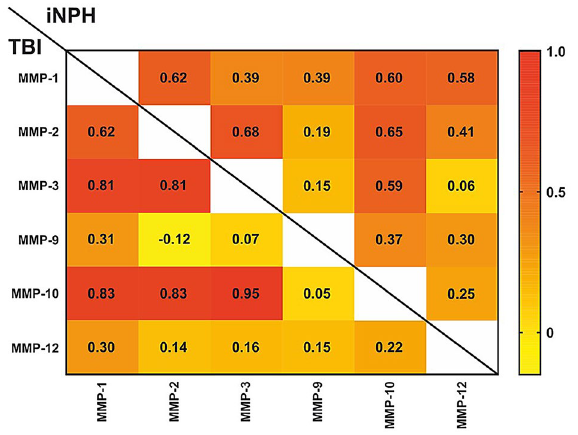
Figure 4. Correlation matrix between the CSF concentrations of MMPs within TBI and iNPH groups separately. The correlation matrix displays Spearman’s correlation coefficients (rho) between the CSF MMP concentrations in TBI (lower-left part) and iNPH (upper-right part) groups. The darker and more red the box, the closer the correlation is to positive 1.